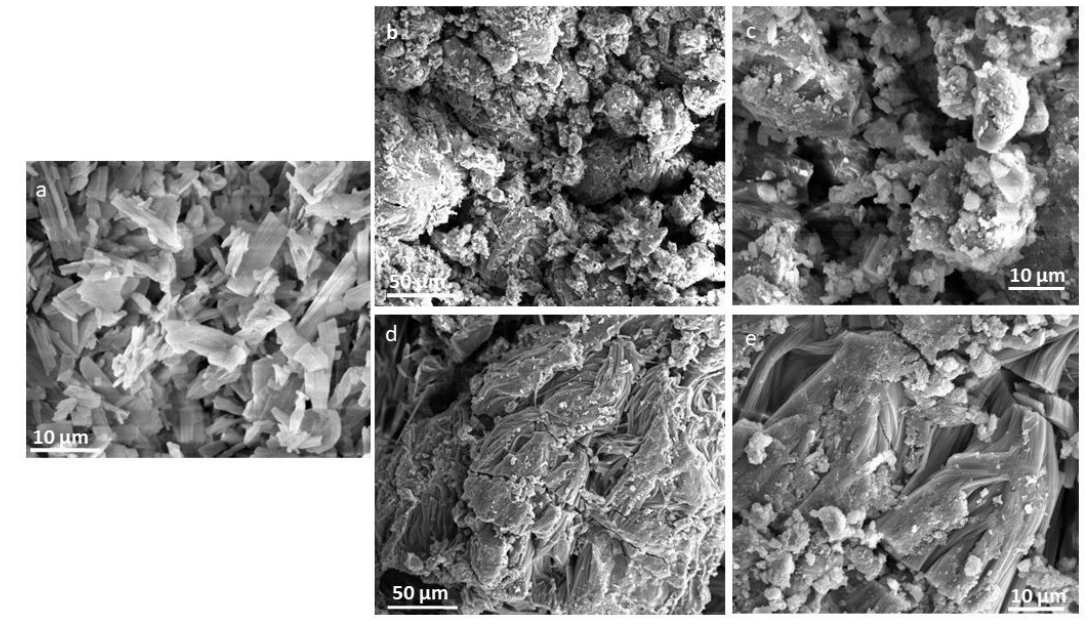
Figure 8. SEM of ( a ) pure drug, ( b , c ) blank, and ( d , e ) DSP-loaded hydrogel